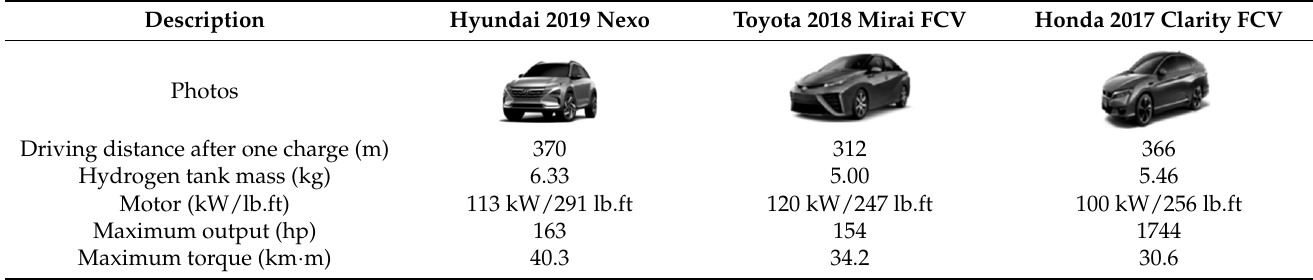
Table 1. Comparison of specifications for the three best-seller models of FC vehicles [17].